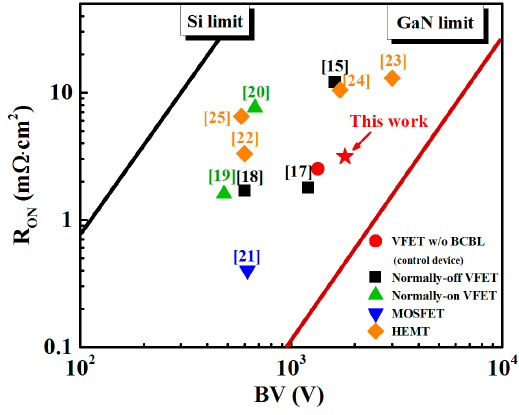
Figure 12. Performance comparisons among the state-of-the-art GaN-based power devices. The red star represents this work (BCBL-VFET).